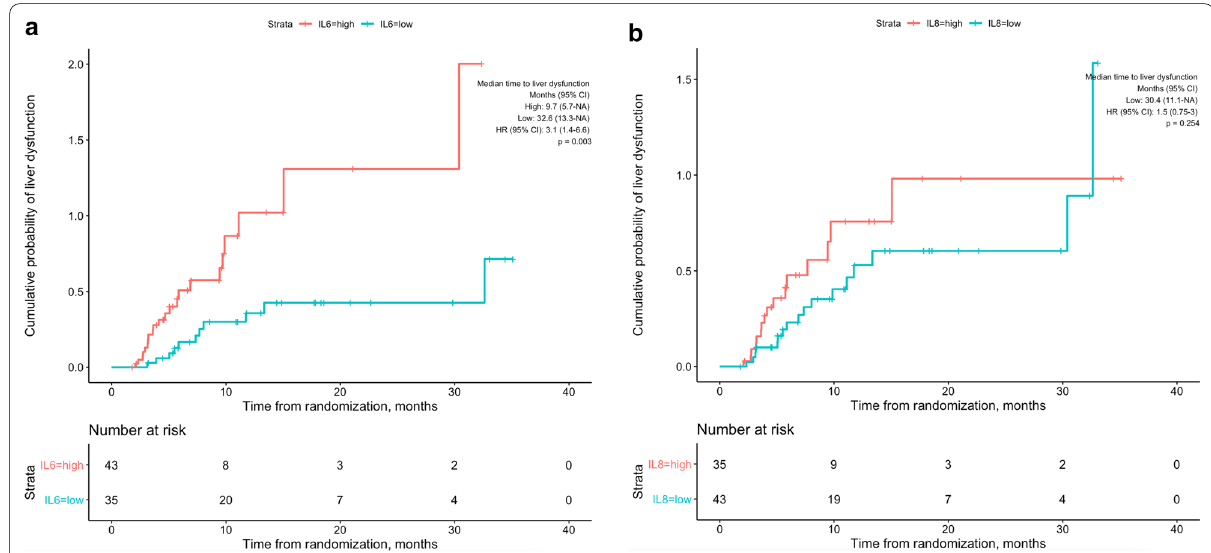
Fig. 3 Kaplan–Meier curves showing time-to-liver dysfunction of patients grouped by high and low baseline IL6 ( a ) and IL8 ( b ) values. P values were calculated using the log rank